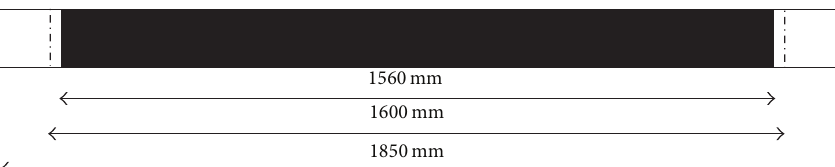
Figure 2: Size of CFL pasted at the bottom of RC